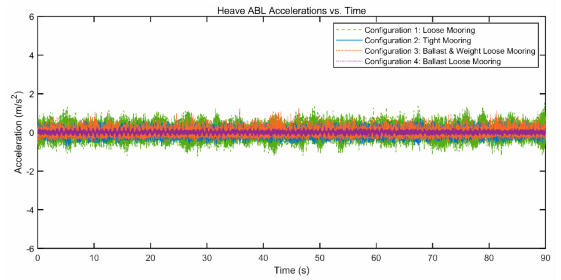
Figure A1. ABL wind heave accelerations for all configurations.